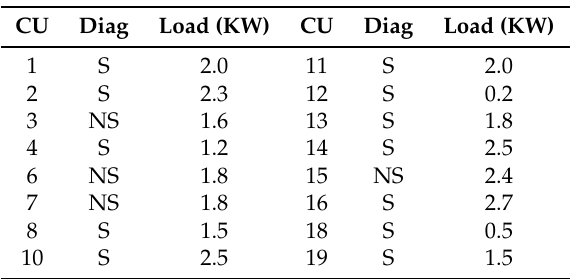
Table 8. Diagnosis Matrix for Load Transfer of Phase